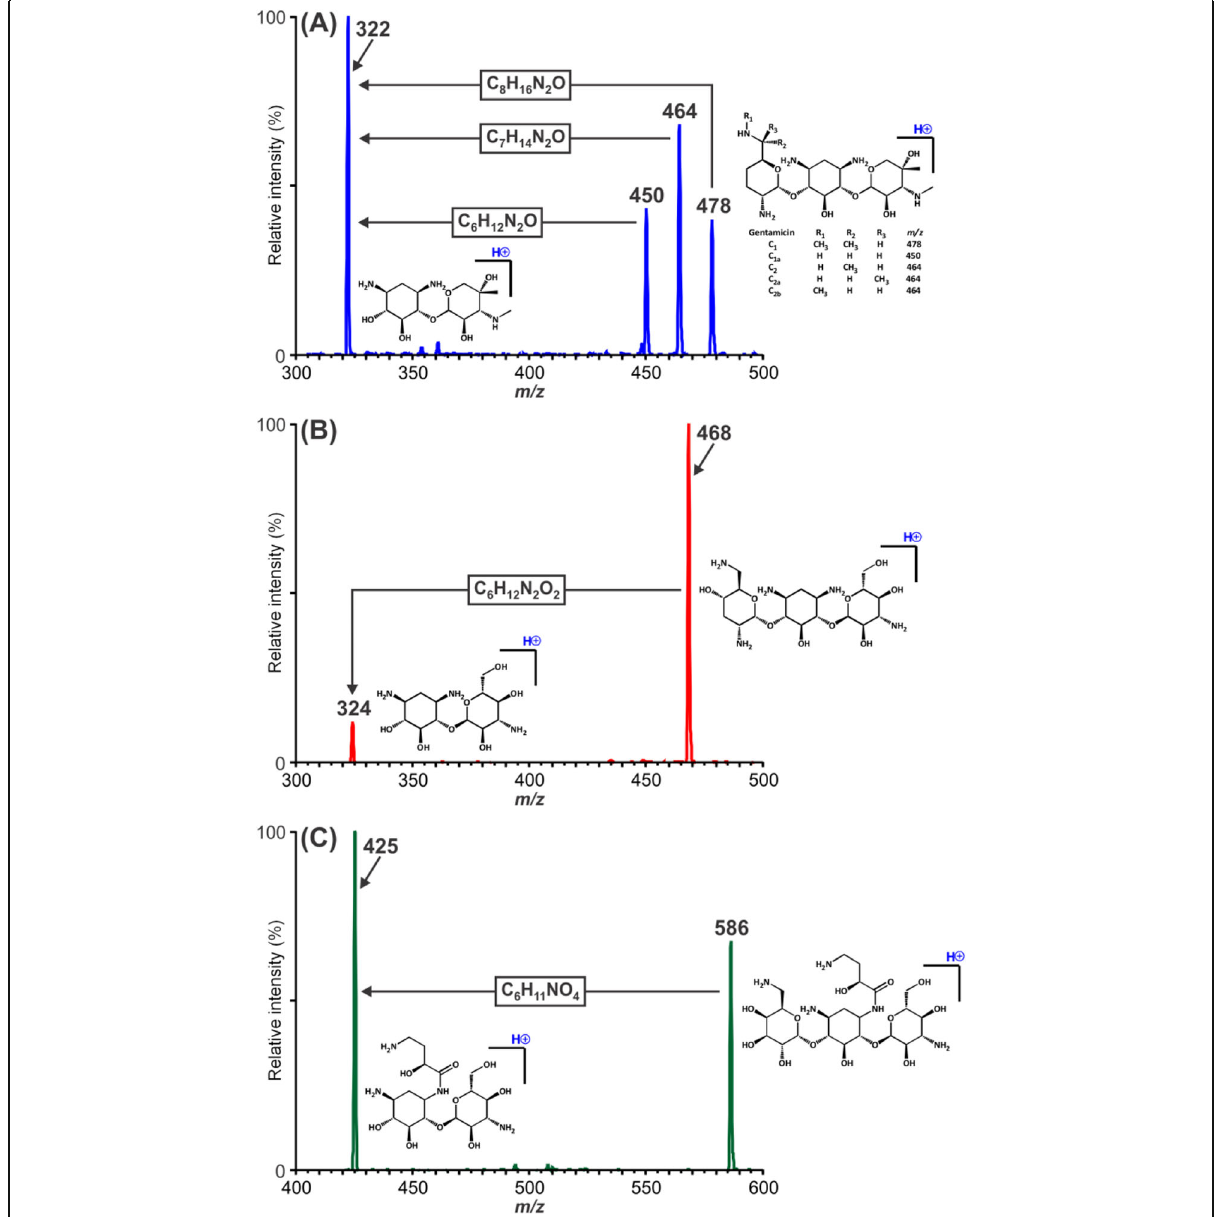
Fig. 2 Precursor-ion spectrum acquired for m/z 322 from a solution of gentamicin ( a ), and those for m/z 324 and 425 from solutions of tobramycin ( b ) and amikacin ( c ),